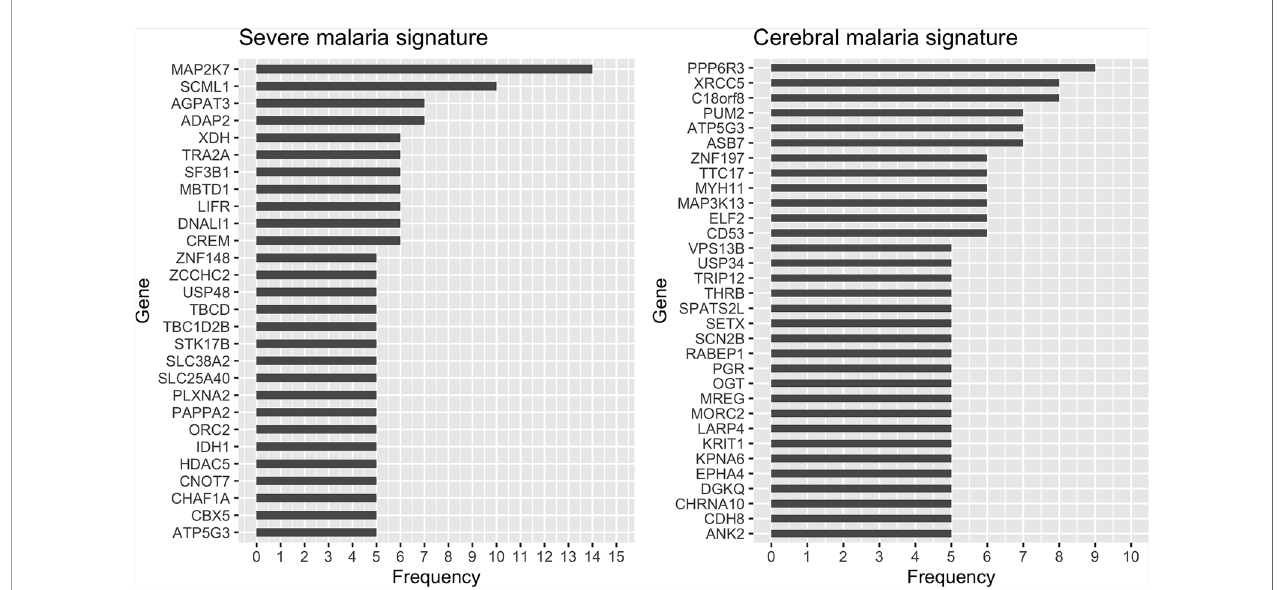
FIGURE 1 | Selection frequency of the genes in the severe (left) and cerebral (right) malaria signatures. Regularized random forest models were run on 100 bootstraps of the training data to select the important features. Features were ordered based on the selection frequency and those frequently selected ( ≥ 5%) were